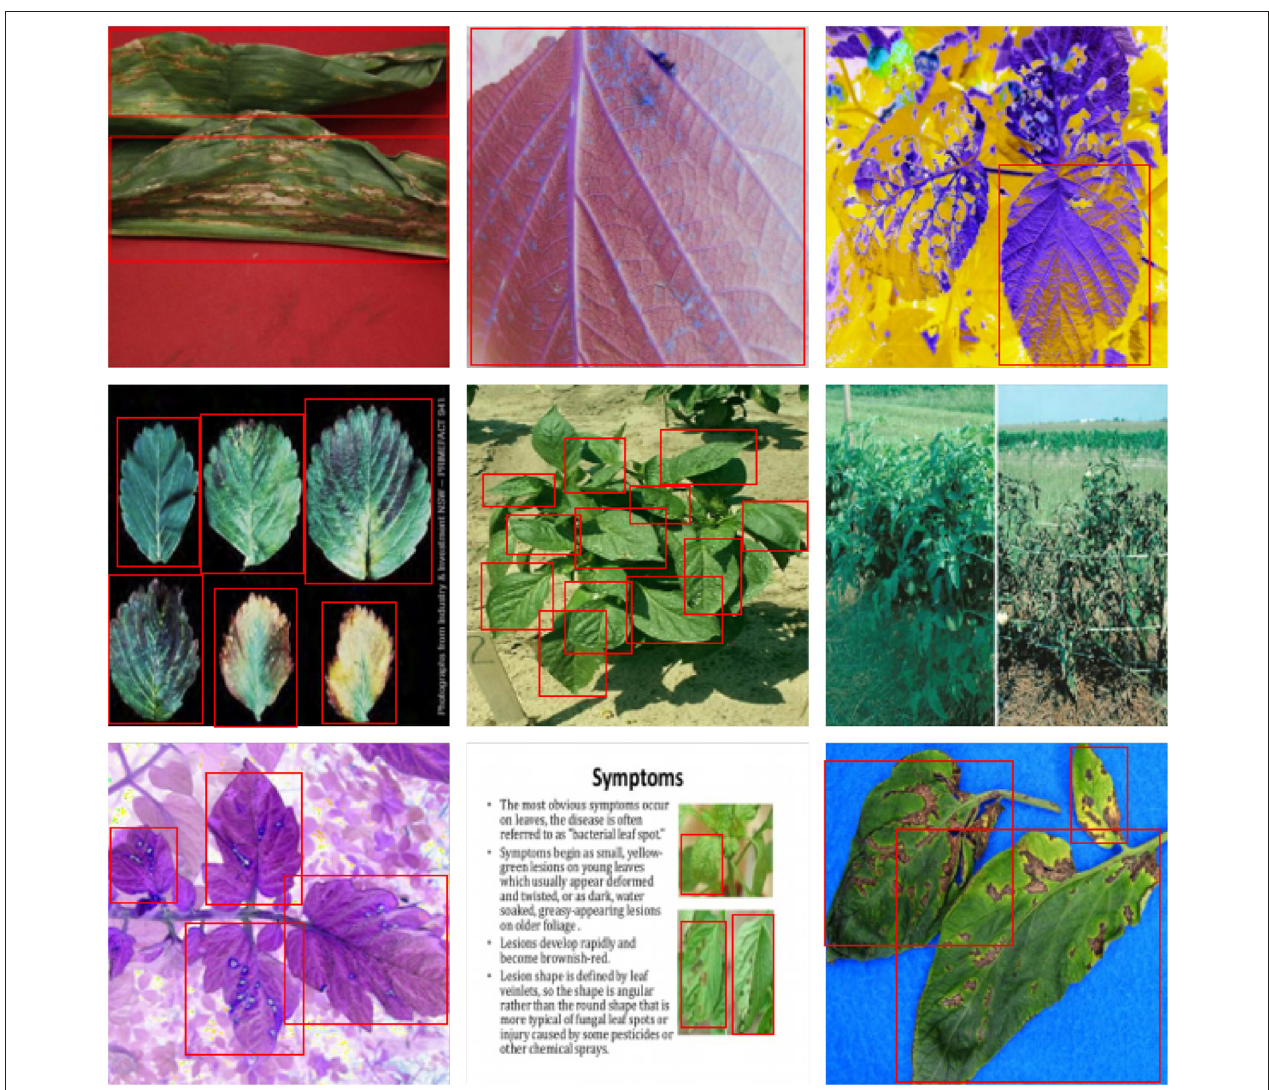
FIGURE 8 | The detection results of SSD in the